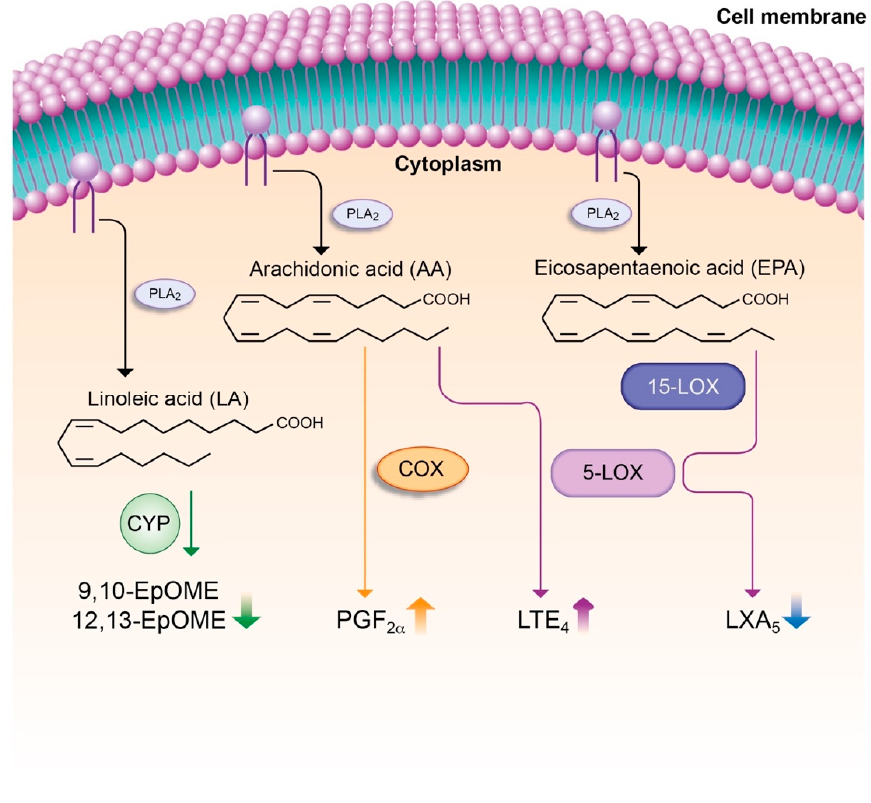
Figure 1. Imbalanced formation between pro-inflammatory and anti-inflammatory lipid mediators in leukocytes from patients with AD cirrhosis and ACLF. In response to inflammatory stimulus, omega-6 (linoleic acid (LA) and arachidonic acid (AA)) and omega-3 (eicosapentaenoic acid (EPA)) polyunsaturated fatty acids (PUFA) are released from cell membrane phospholipids into the cytosol by phospholipase A 2 (PLA 2 ). In the cytosol, unesterified free PUFA serve as available substrates for cyclooxygenase (COX), lipoxygenase (5-LOX/15-LOX) and cytochrome P450 (CYP) enzymatic pathways, which generate an array of bioactive lipid mediators. Patients with AD cirrhosis and ACLF present elevated levels of AA-derived pro-inflammatory and vasoconstrictor lipid mediators such as LTE 4 and PGF 2 α , in parallel with decreased levels of the EPA-derived product LXA 5 , which is an anti-inflammatory and pro-resolving lipid mediator. In addition, the CYP-products derived from LA, 9,10-EpOME and 12,13-EpOME, which are produced by leukocytes during oxidative burst, were remarkably suppressed in ACLF patients, indicating poor bactericidal activity.